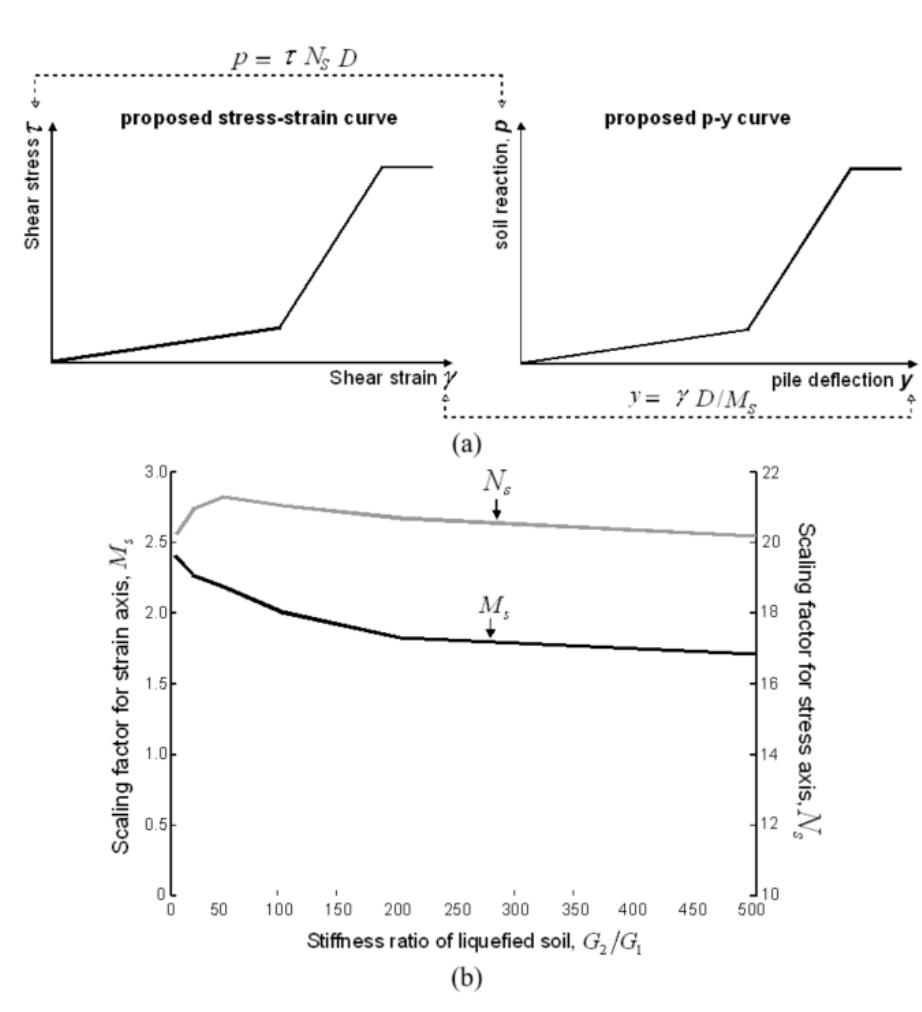
Figure 41. ( a ) Proposed scaling approach for derivation of p – y curves from the stress–strain curve; ( b ) computed scaling factors M s and N s for different stiffness ratios G 2 /G 1 .